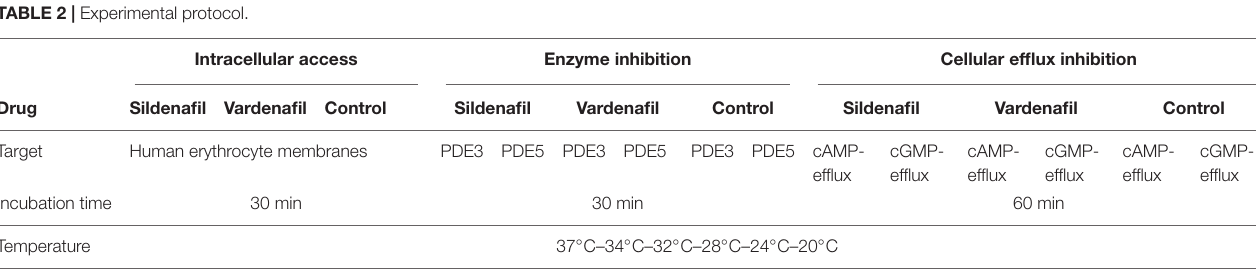
TABLE 2 | Experimental